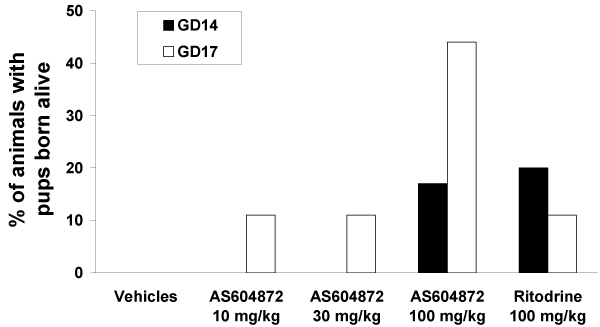
Effects of AS604872 and ritodrine on viability of preterm mouse pup. Data are expressed as % of dams that delivered live pups following labor induction by RU486 at GD14 or GD17 and treatment with different oral doses of AS604872 or ritodrine. The mean total number of pups (abortion, born dead and born alive) for each treatment group (9–11) was not statistically different.